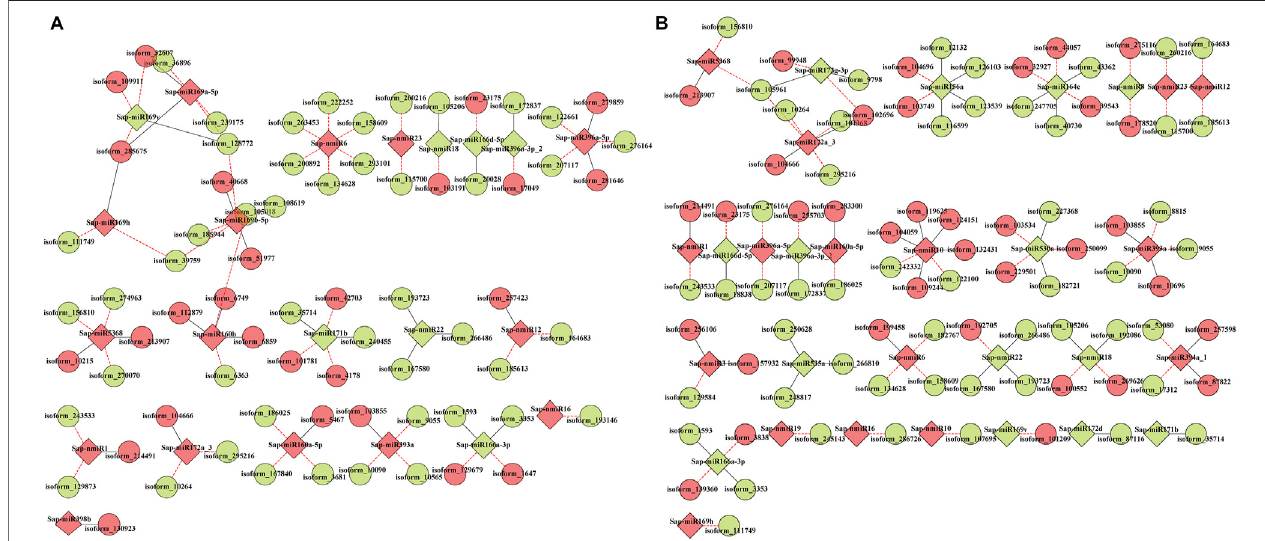
FIGURE 6 | Co-expressed miRNA-target pairs of Sonneratia -speci fi c in samples treated with salt for 1 day (A) and 28 days (B) . Solid lines represent positive correlations and dashed lines represent negative correlations. miRNAs and targets are marked by rhombus and circles, respectively; red/green shading represents down/up regulated miRNAs or target